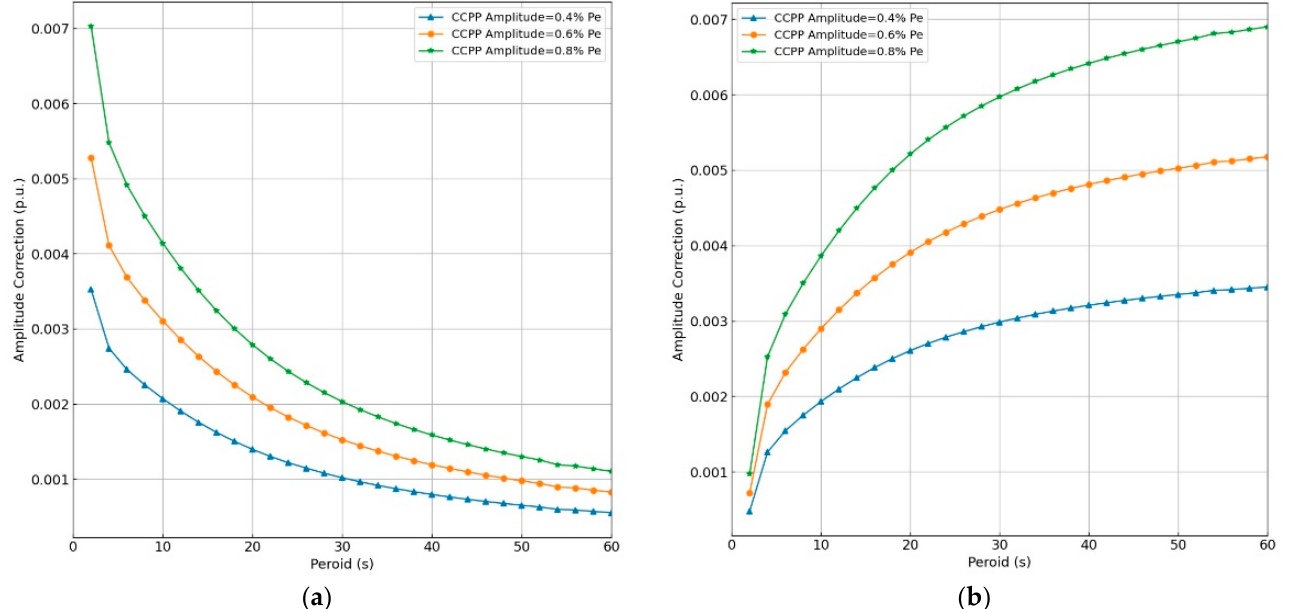
Figure 9. Oscillating load-mutation faults of CCPP. ( a ) Amplitude Value. ( b ) Amplitude Correction Value.